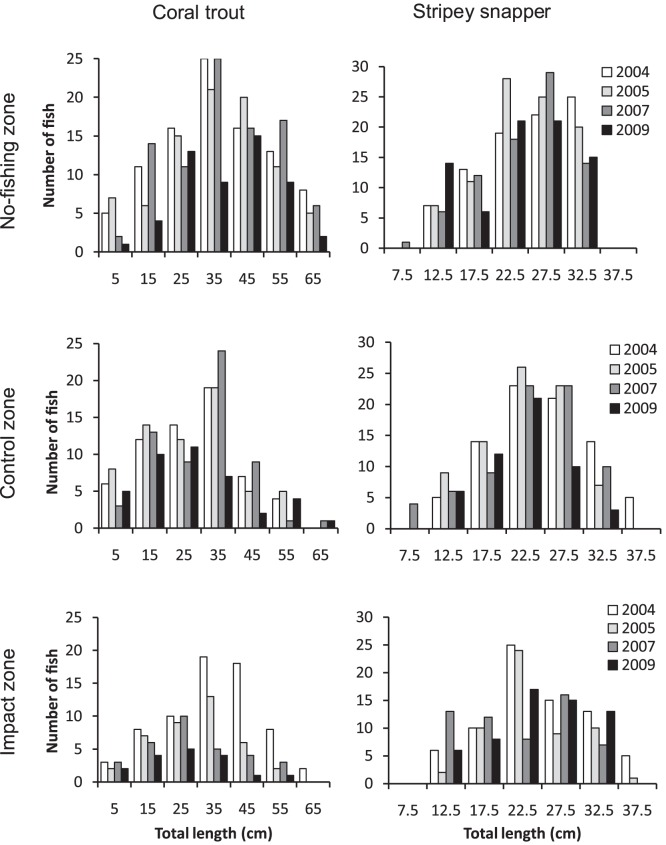
Length-frequency distributions of coral trout and stripey snapper.Data originate from 40 underwater visual transects per zone per year. The management history of each zone is described in Figure 2. The x-axis labels are size-category midpoints. Minimum legal sizes of coral trout and stripey snapper are 38 and 25 cm total length respectively.